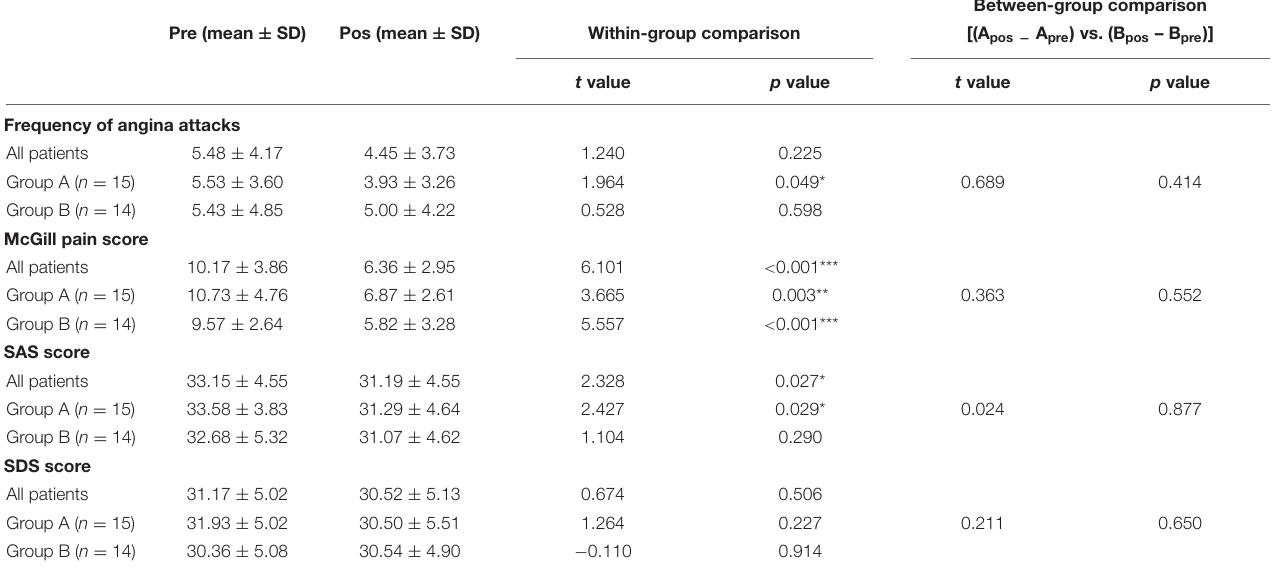
Between-group comparison